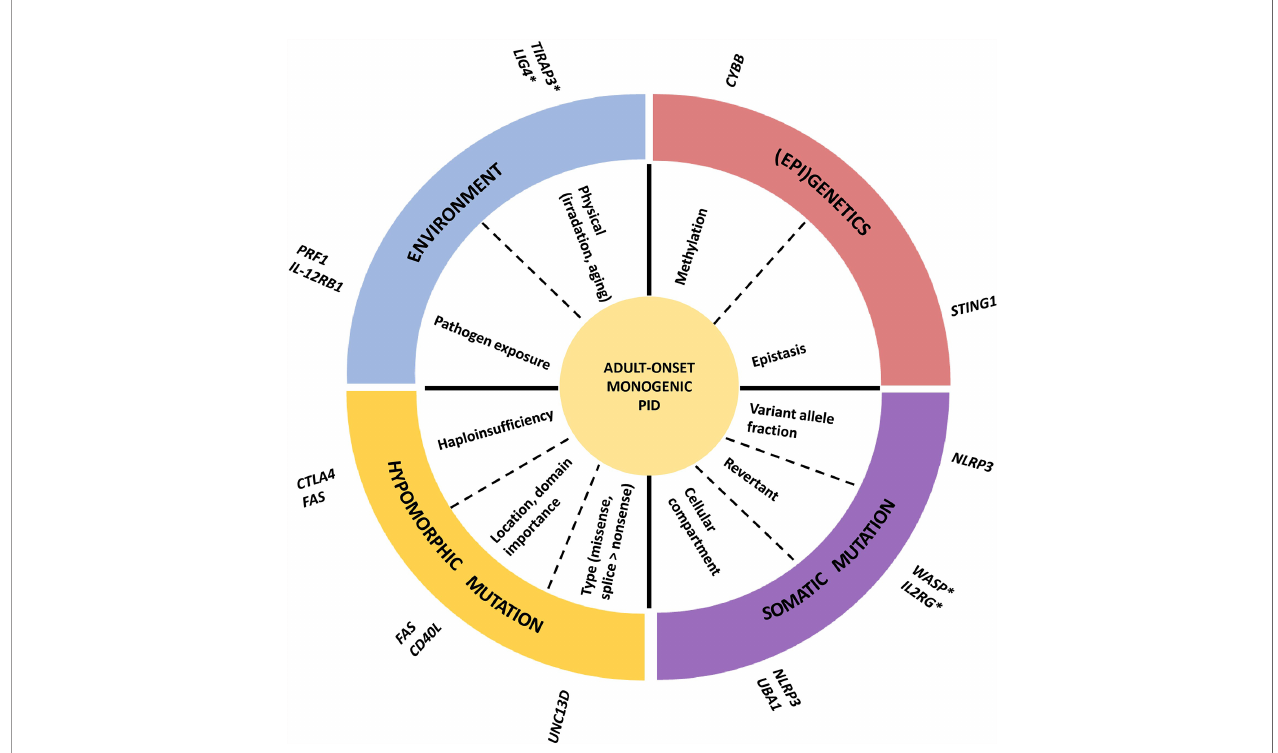
FIGURE 2 | Mechanism of adult-onset IEI. An example of one or two genes is given for every mechanism. *late onset phenotype, but not